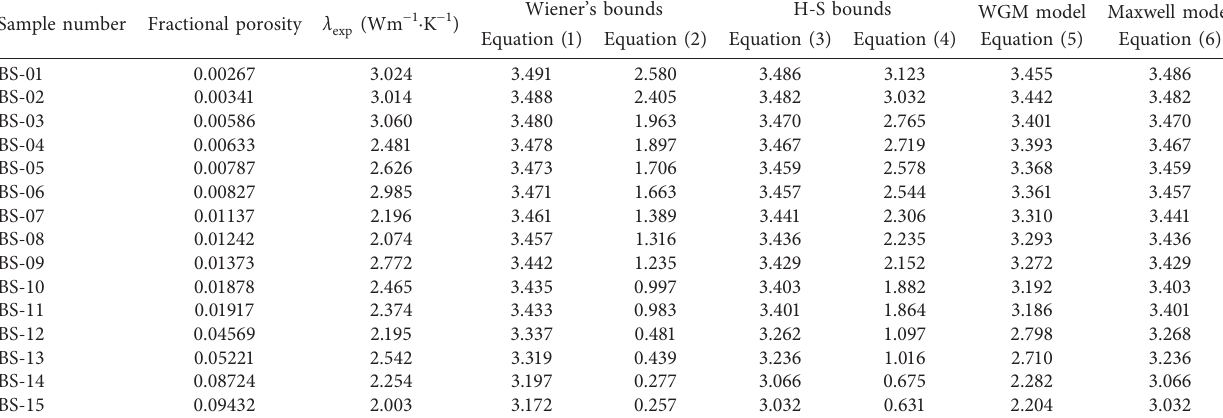
Table 4: Fractional porosity, experimental thermal conductivity, and effective thermal conductivity obtained after using upper and lower thermal conductivity bounds.